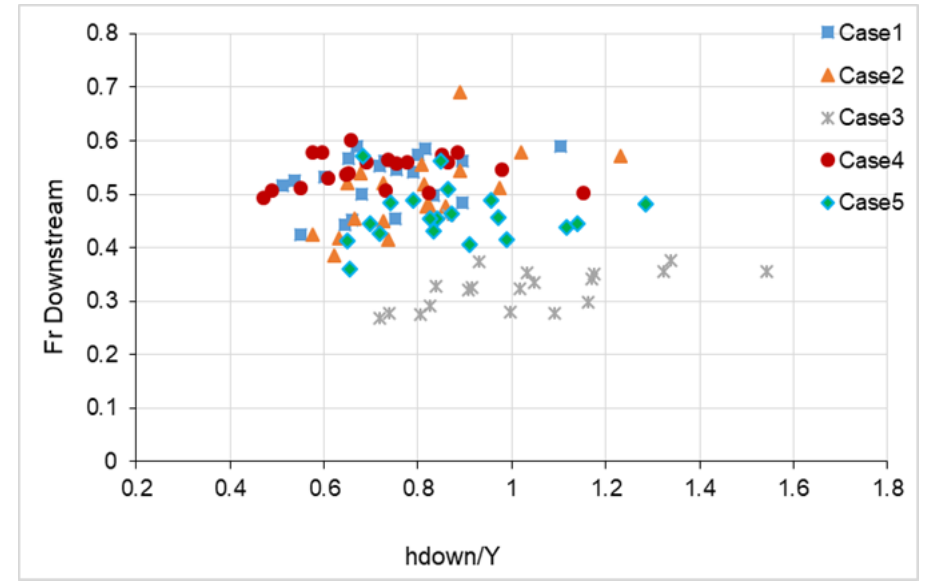
Figure 5. Relation between downstream Froude number and h-downstream⁄y